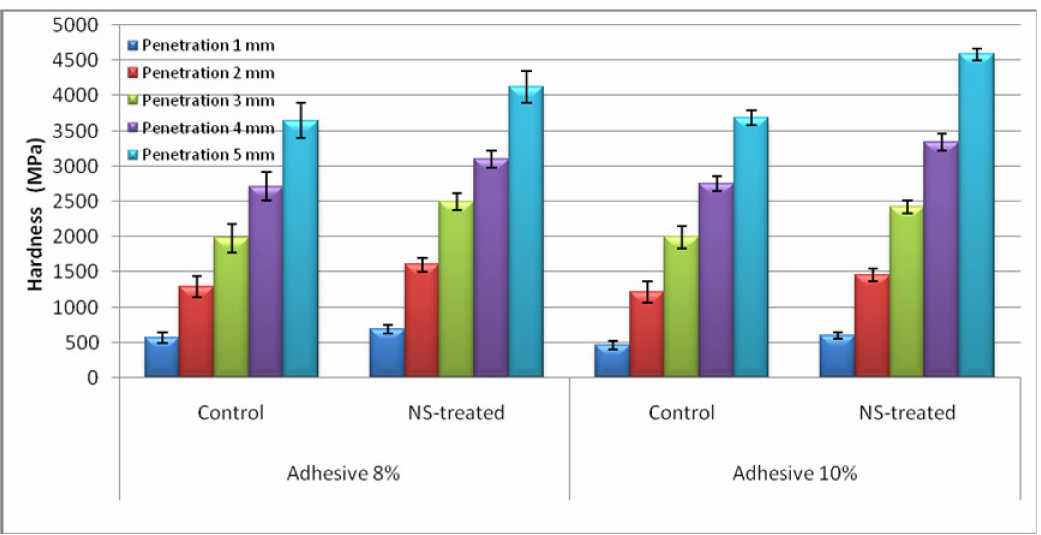
Figure 8. Hardness values (MPa) for the four treatments studied; for each treatment, five hardness values represent for five depths of penetration (NS = nano-sepiolite).